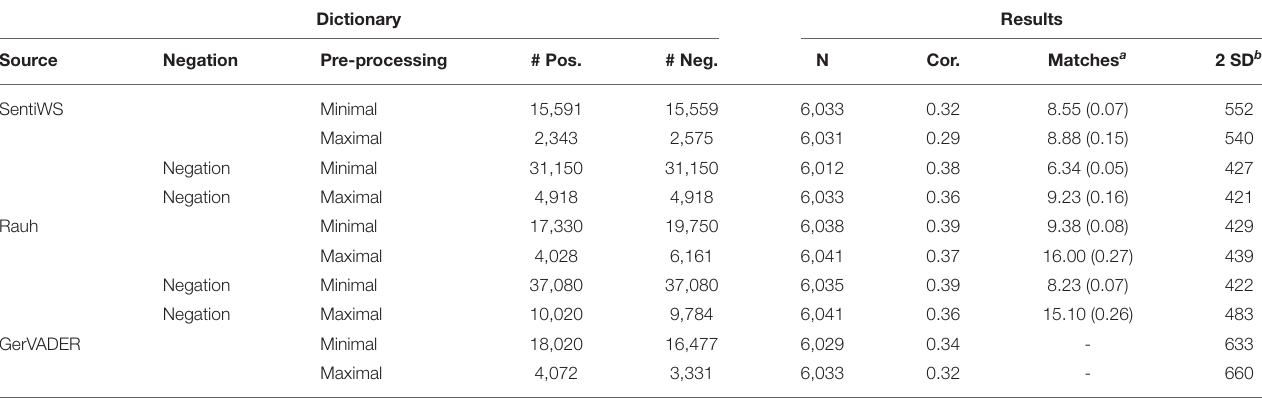
TABLE 3 | Characteristics and results for prefabricated dictionaries.